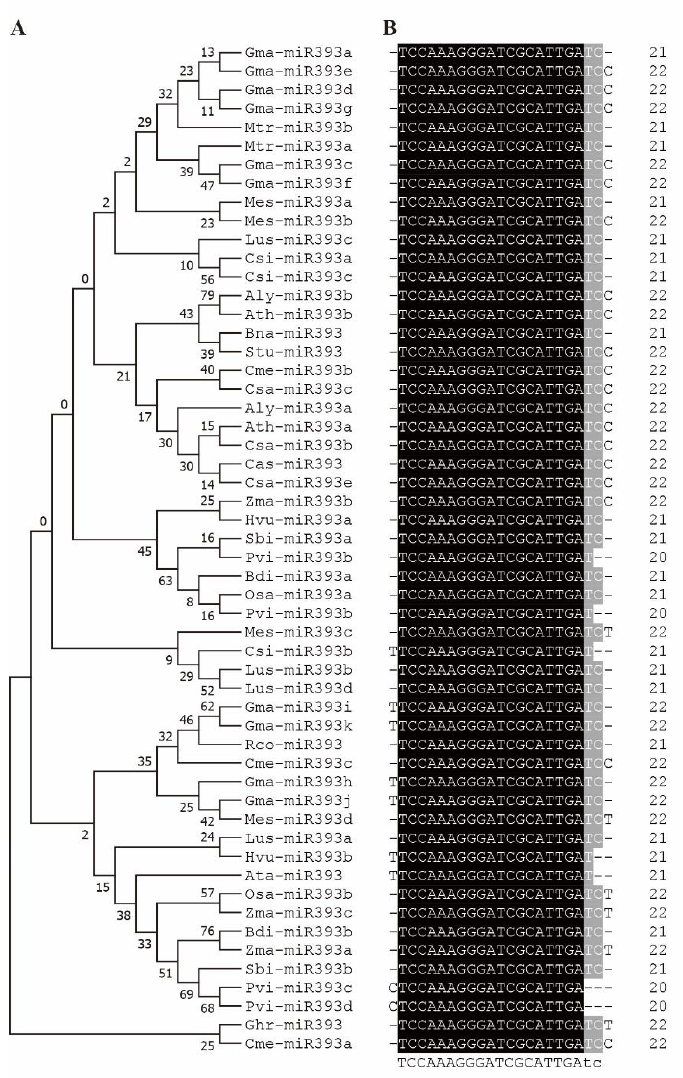
Figure 1. The conserved sequence similarity of miR393 members in different plants. ( A ) Phylogenetic relationships of pre-miR393s; ( B ) sequence similarity of mature miR393s. Aly, Arabidopsis lyrata ; Ata, Aegilops tauschii ; Ath, Arabidopsis thaliana ; Bdi, Brachypodium distachyon ; Bna, Brassica napus ; Cas, Camelina sativa ; Cme, Cucumis melo ; Csa, Cucumis sativus ; Csi, Camellia sinensis ; Ghr, Gossypium hirsutum ; Gma, Glycine max ; Hvu, Hordeum vulgare ; Lus, Linum usitatissimum ; Mes, Manihot esculenta ; Mtr, Medicago truncatula ; Osa, Oryza sativa ; Rco, Ricinus communis ; Sbi, Sorghum bicolor ; Stu, Solanum tuberosum ; Zma, Zea mays ; Pvi, Panicum virgatum .